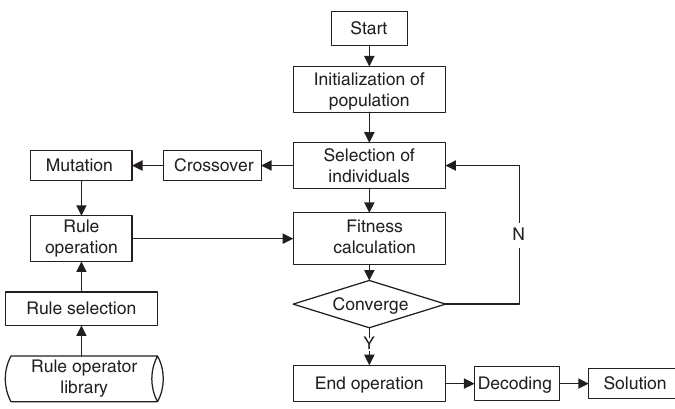
Figure 1 Flowchart of GA-associated rule operator.